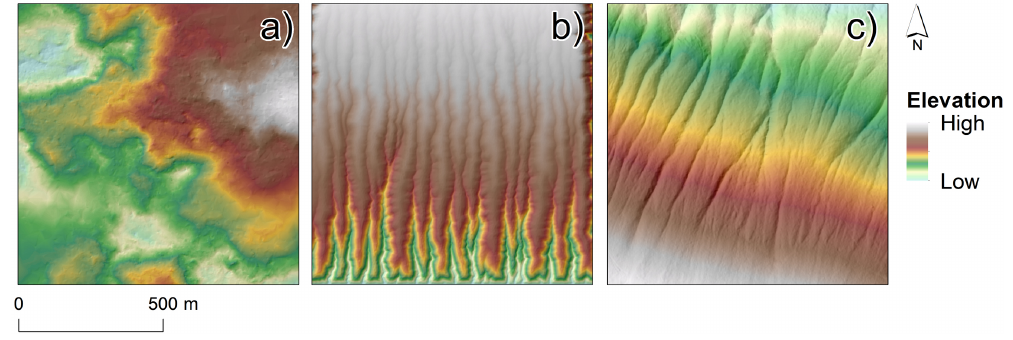
Figure 5. Comparison of simulated DEMs in (a) and (b) with lidar measurement of a real landscape in the south of Italy in (c) . (a) Fractional Brownian motion (Mandelbrot, 1983); initial roughness of the surface = 0.2, initial elevation of the surface = 0.0, and change of roughness over change of terrain = 0.005. Output is dimensionless, but is effectively given the same scale and resolution as (c) by assigning each pixel a 2 × 2m size. (b) A landscape model (Refice et al., 2012) that evolves through time a southward-dipping initial topography containing small-scale randomness, with all four boundaries closed except the lower right corner. Simulated time is ∼ 30kyr and the run parameters are tectonic uplift u f = 1mmyr − 1 ; diffusivity constant k d = 0.2m 2 yr − 1 ; with channelling parameters of K c = 10 − 4 m (1 − 2 m ) yr − 1 , m = 0 . 5, and n = 1. The spatial dimensions of (b) are as in (c) . Centroid in (c) is 14 ◦ 37 (cid:48) 59.46 (cid:48)(cid:48) E, 40 ◦ 43 (cid:48) 25.80 (cid:48)(cid:48) N.